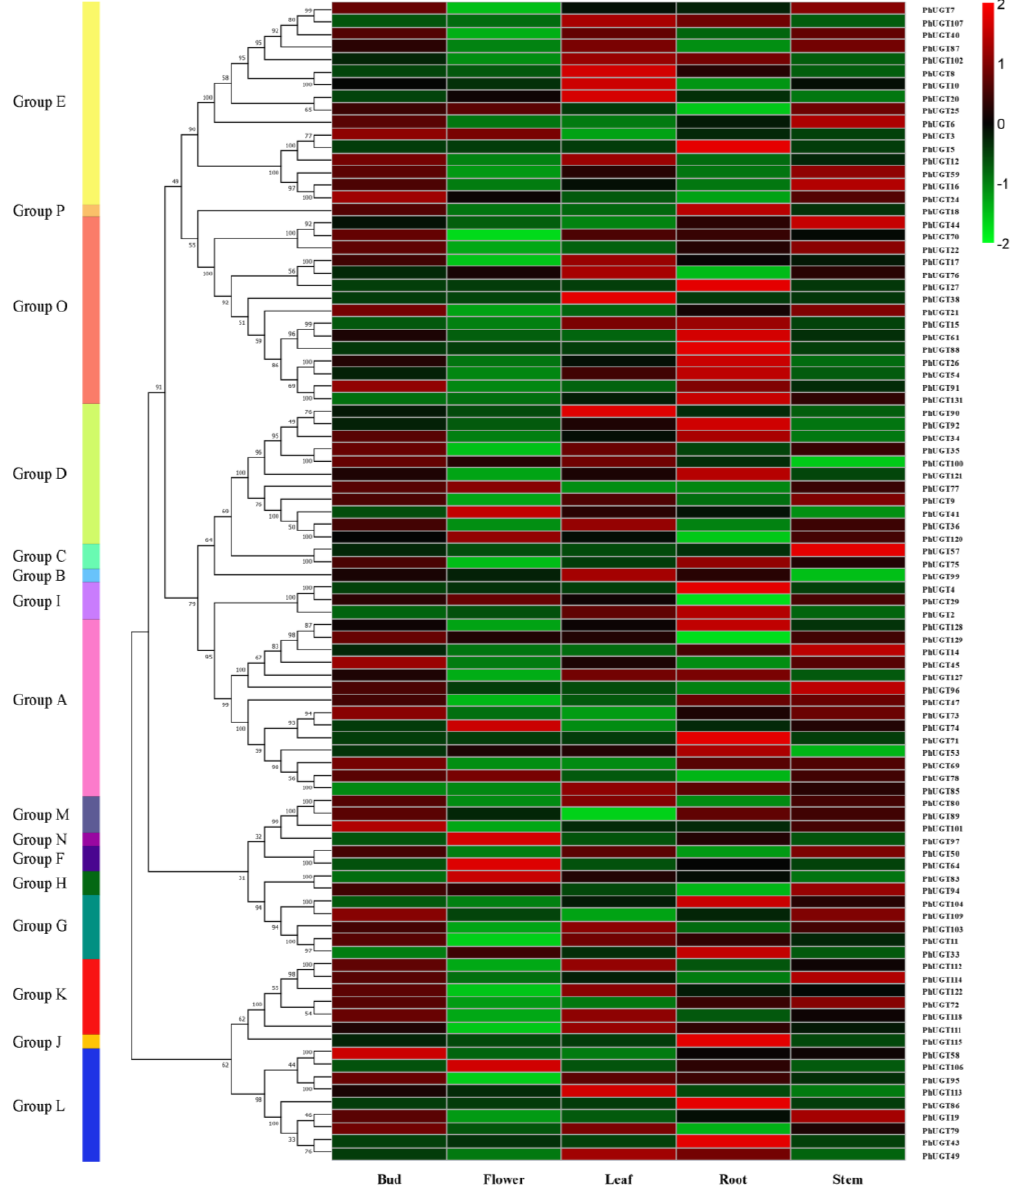
Figure 4. Expression heat map of different tissues of Petunia UGT family members.